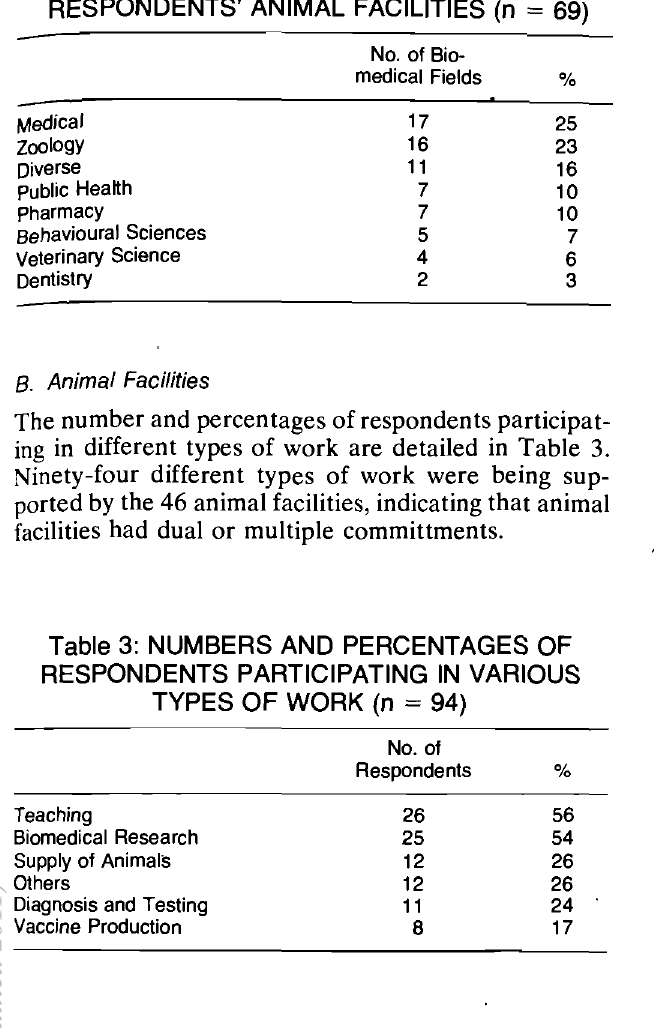
FACILITIES IN JULY 1977